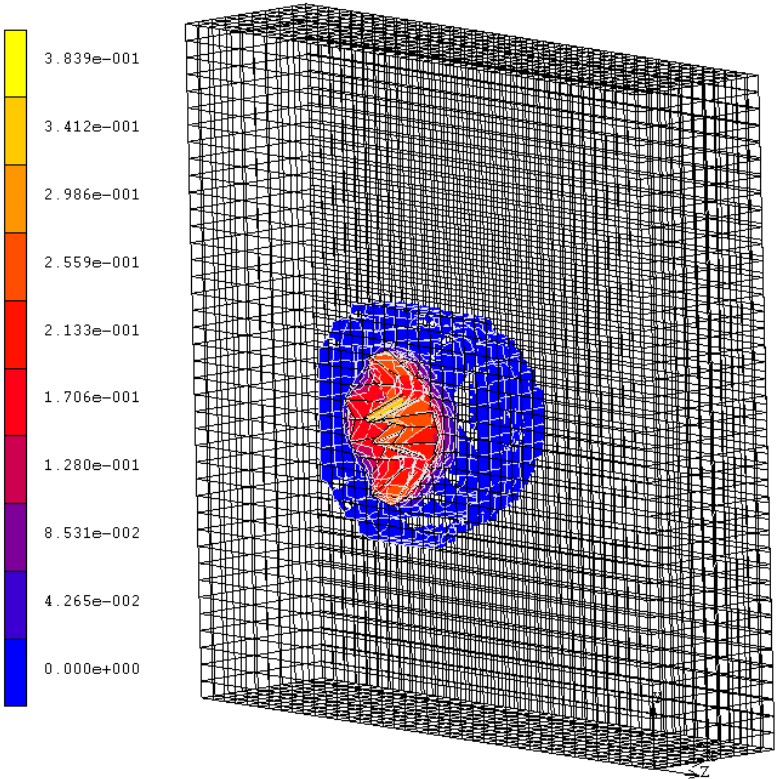
Figure 4. Plastic strain ( − ) at the front surface impacted: iso-surface representation at t = 2.1 × 10 − 3 sec.